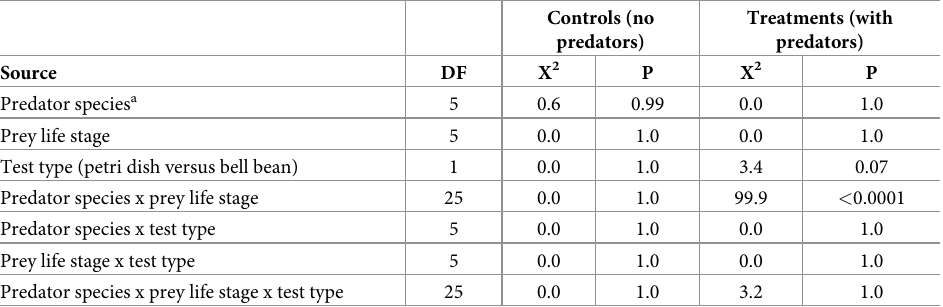
Table 1. Results of generalized linear models with binomial error that tested for effects of predator species, prey life stage, test type, and all interaction terms on Spissistilus festinus mortality in control treatments (no predators) and in predator treatments. (P �